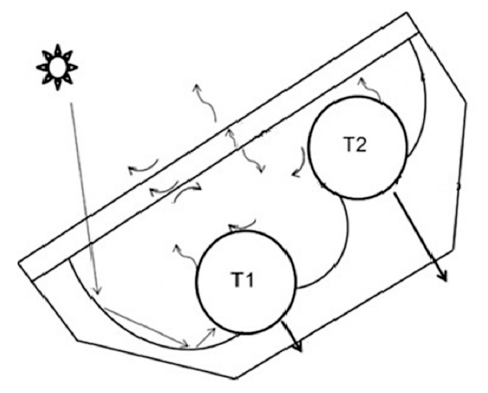
Figure 30. Cross-section of the ICS with CPC and double storage tanks [63].